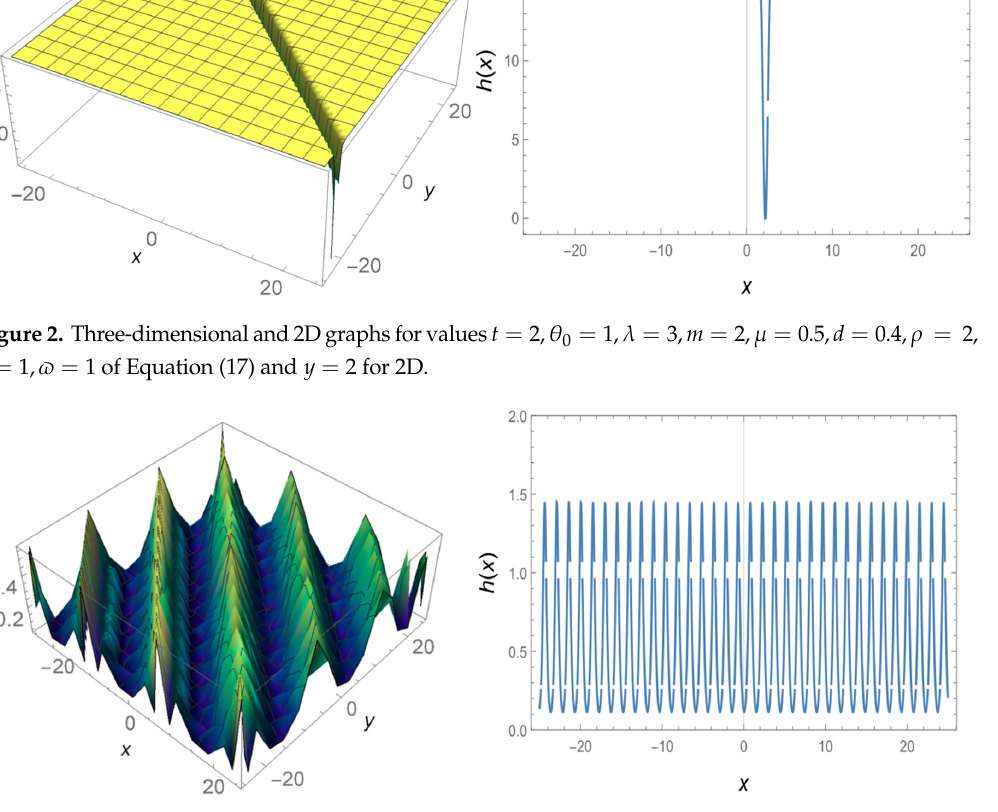
Figure 3. Three-dimensional and 2D graphs for values t = 2, θ 0 = 1, λ = 3, m = 2, d = 1, τ = 1, b = − 1, (cid:36) = 1 of Equation (19) and y = 2 for 2D.